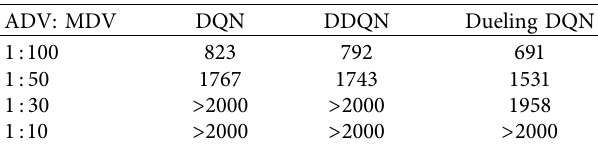
Table 6: Comparison of convergence episodes with diferent ADV